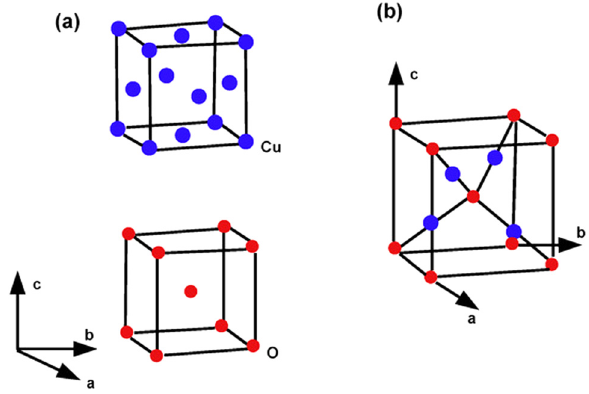
Figure 1: ( a ) Copper oxide ( Cu O 2 ) structural features where Cu are copper and O are oxygen atoms and ( b ) unit cell of copper oxide ( Cu O ) lattice. 2